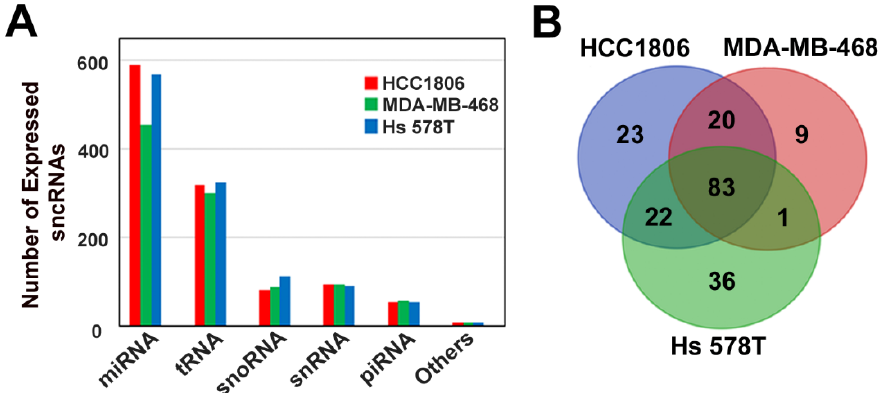
Figure 1. Characterization of small noncoding RNA (sncRNA) expression profiles in triple-negative breast cancer (TNBC) cell lines. ( A ) Bar plot showing the number of expressed microRNAs (miRNAs), transfer RNA (tRNAs), small nucleolar RNAs (snoRNAs), small nuclear RNAs (snRNAs), PIWI-interacting RNA (piRNAs), and other small noncoding RNAs (sncRNAs) in the indicated cell lines. Only sncRNAs whose expression level exceeded three normalized reads are reported. ( B ) Venn diagram showing the number of common and specific miRNAs, highly expressed (expression level above the third quartile of the normalized read-count) in TNBC cell